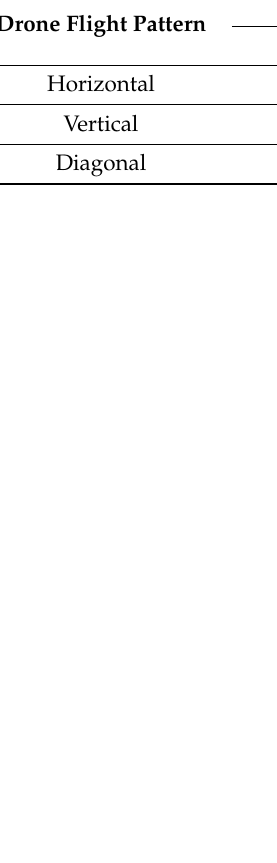
Table 6. Dust reduction for all patterns. Table 5. Power analysis of different drone flight methods (100 CC).